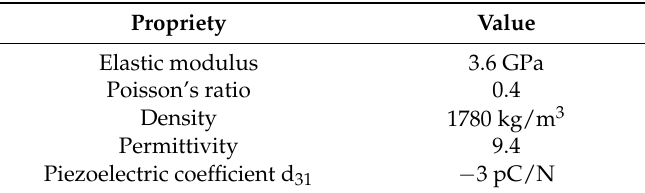
Table 1. Main properties of PVDF–TrFE.